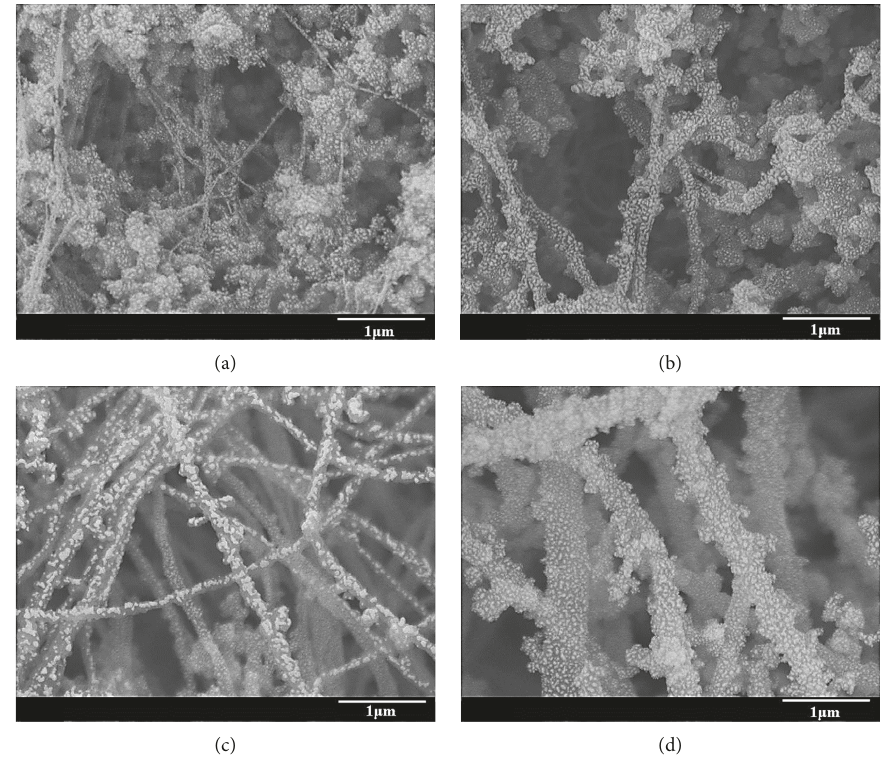
Figure 4: FEG-SEM micrographs of BNC/Ppy · CuCl (c) BNC/Ppy · CuCl 2 0.08 2:1, and (d) BNC/Ppy · CuCl 2 0.08 4 :1.